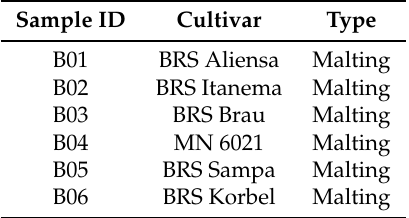
Table 1. Barley cultivars employed in the experimentation.B, malting Barley; N, Naked